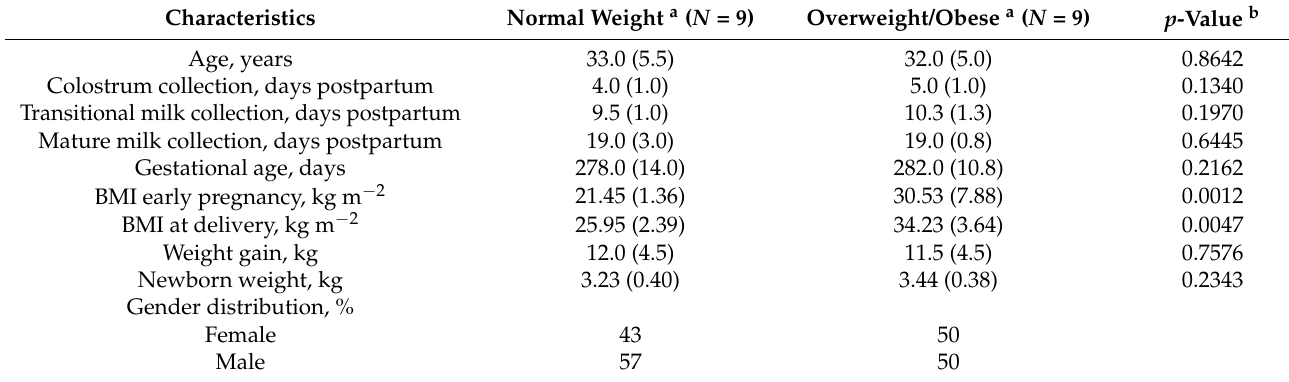
Table 1. Demographic description of study mothers and delivery characteristics by